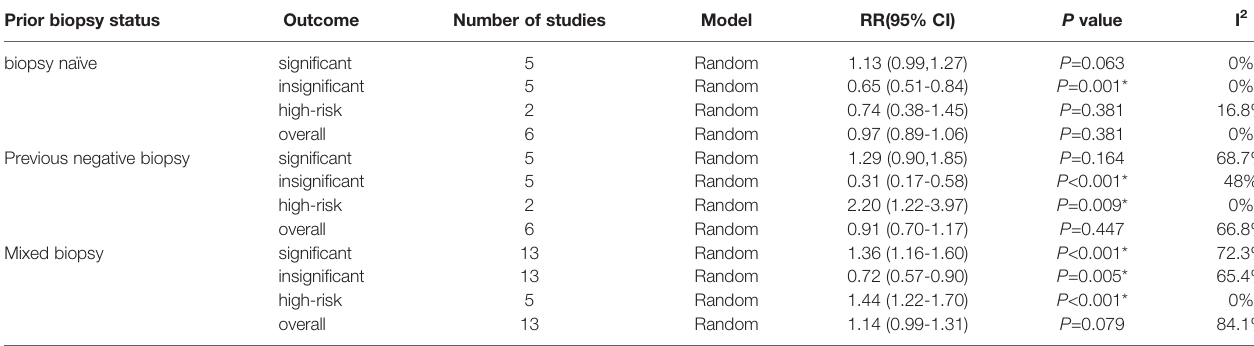
TABLE 4 | Subgroup analyses of MRI-TB versus SB in the diagnosis of prostate Cancer. Prior biopsy status